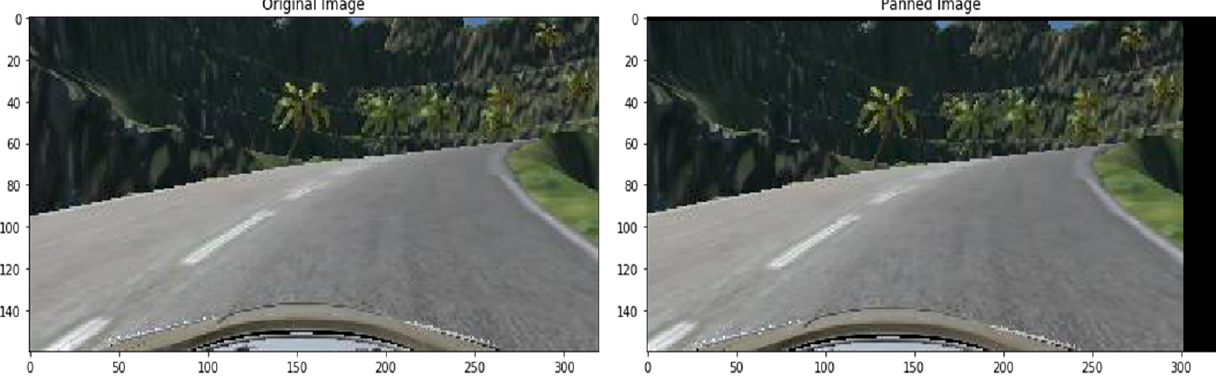
Figure 11. Zoomed image.